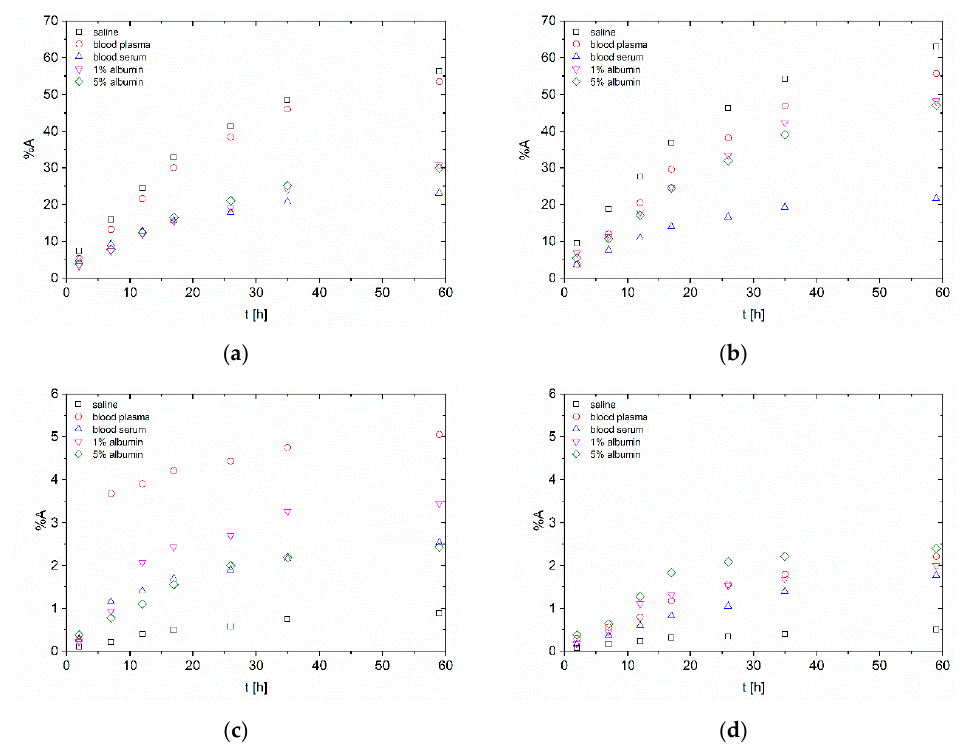
Figure 1. Short-term in vitro stability study of 223 Ra-labelled nanoparticles ( a ) surface radiolabelling of n HAp; ( b ) intrinsic radiolabelling of n HAp; ( c ) surface radiolabelling of n TiO 2 ; ( d ) intrinsic radiolabelling of n TiO 2 .